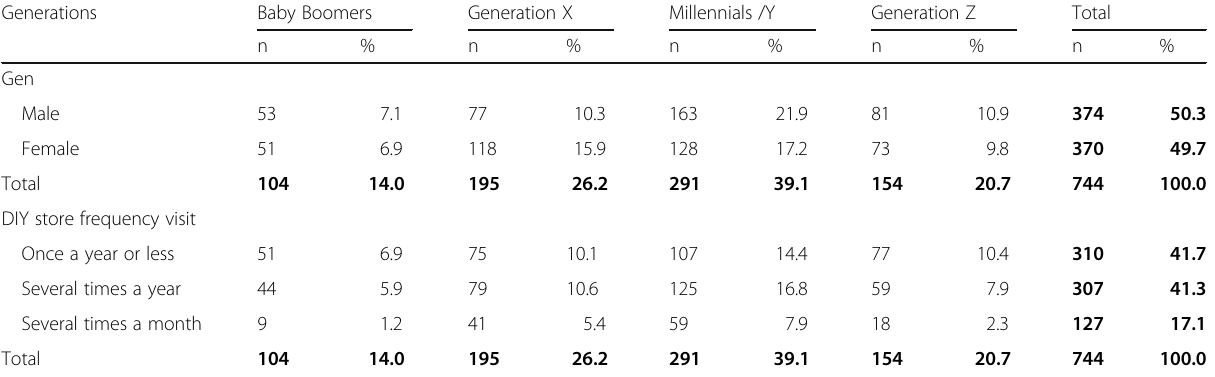
Table 3 Socio-demographic characteristics of the sample Generations Baby Boomers